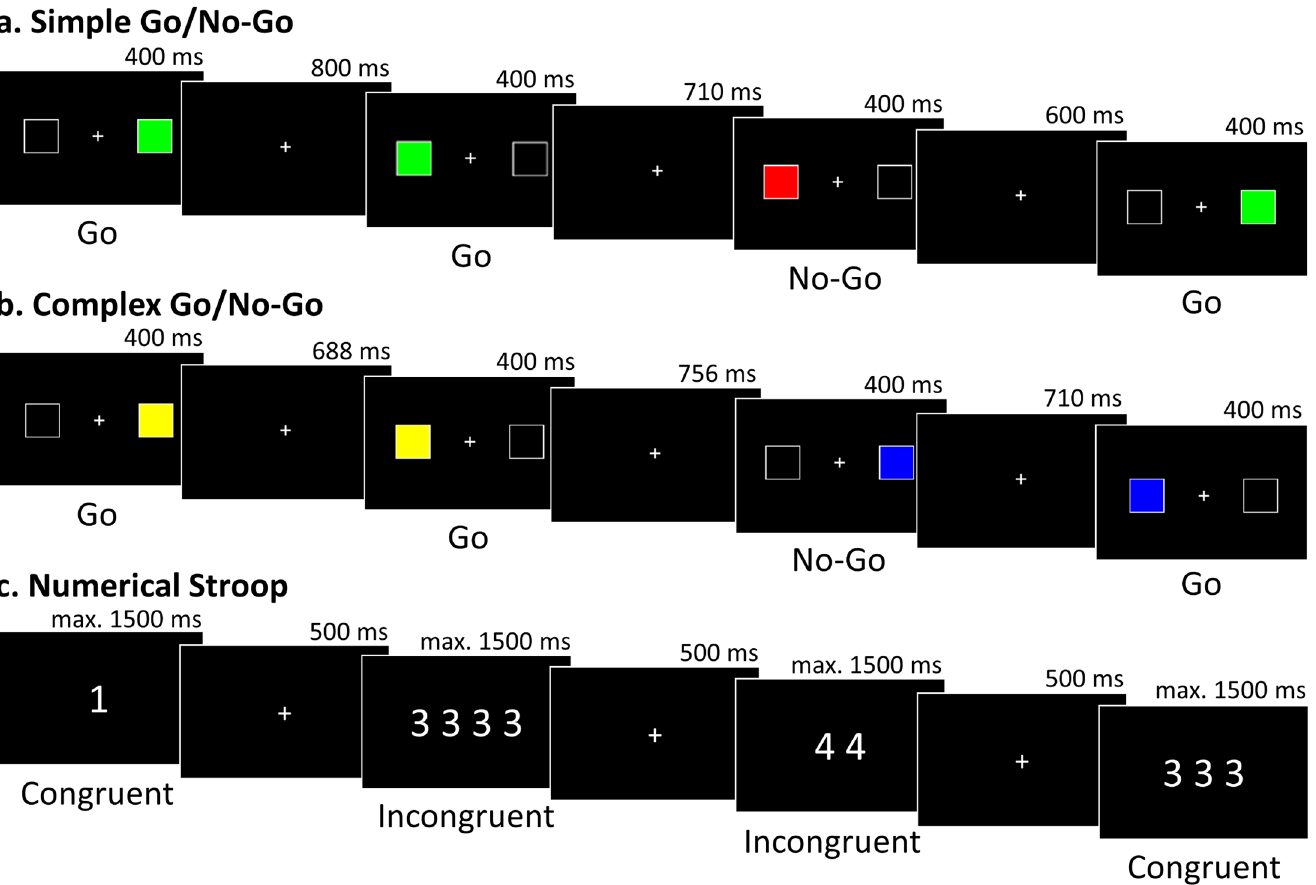
Fig 2. Example time course of events in the inhibitory control tasks. (a) In the simple Go/No-Go, participants pressed the left or right key to indicate the location of the green square (Go trials), but withheld their response when the square was red (No-Go trials). (b) In the complex Go/No-Go, participants pressed the left or right key to indicate the location of the coloured square (Go trials), but withheld their response when a blue square followed a yellow square (No-Go trials). In both tasks 25% of trials were No-Go, as in previous studies (e.g. [29]), so that non-responses were infrequent and thus harder to inhibit, and the inter-stimulus interval was jittered between 600 and 800 ms. (c) In the numerical Stroop, participants pressed the key corresponding to the number of digits on the screen. On congruent trials, the number of digits and the digits themselves matched, while on incongruent trials they differed and participants had to inhibit the representation of the digits. Fifty percent of trials were incongruent as in prior tests of semantic inhibition (e.g. [21]) to maintain high levels of conflict and allow accuracy and RT comparisons between trial types. Stimuli remained on the screen until the participant responded or for a maximum of 1500 ms.